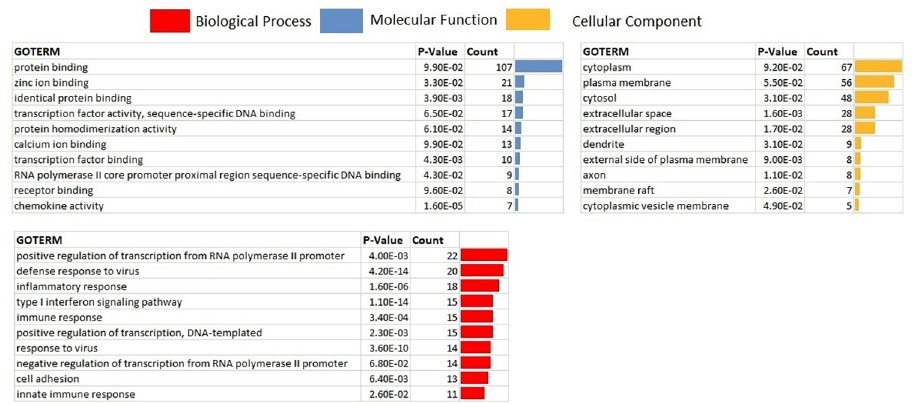
Fig 5. Gene ontology analysis of differentially expressed genes. Top GO terms with lowest P-values in cellular component, molecular function, and biological process were shown, respectively.